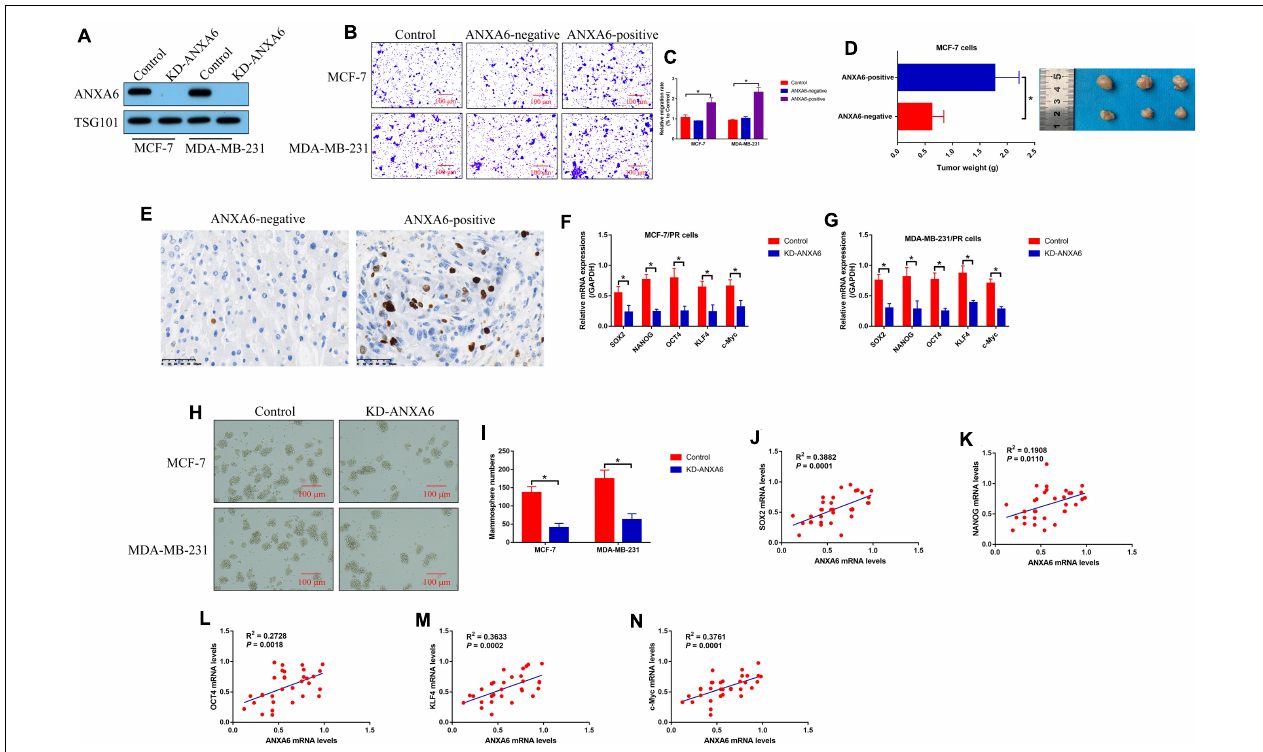
FIGURE 3 | BCSC-secreted exosomes promoted tumor migration, growth, and stemness via delivering ANXA6. (A) ANXA6 was silenced in PR-BC-derived exosomes, which were verified by Western blot analysis. The BCSC-derived exosomes with or without ANXA6 were co-cultured with the PS-BC cells. (B,C) Cell migration abilities were examined by Transwell assay. (D) In vivo BC cell growth was monitored, and (E) Ki67 protein levels in mouse tumor tissues were measured by immunohistochemistry (IHC) assay. (F,G) Cell stemness-associated proteins were determined by real-time qPCR, and (H,I) spheroid formation abilities in BC cells were determined by spheroid formation assay. (J–N) The correlations between ANXA6 mRNA and stemness-associated biomarkers in clinical BC tissues were analyzed by performing Pearson correlation analysis. A single experiment had three repetitions, and * p < 0.05 was regarded as statistical